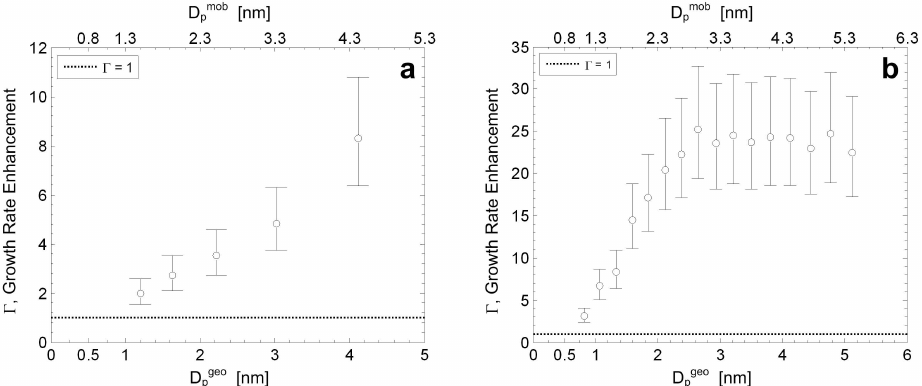
Fig. B1. Effect of systematic uncertainties in [H 2 SO 4 ] on growth rate enhancement 0 as a function of particle mobility diameter D mob p (upper abscissa) and particle geometric diameter D geo p (lower abscissa) for the NPF event observed on (a) 7 August 2009 (09:50, NCCN) and on (b) 19 September 2010 (12:40–13:00, NCAR). Values of 0 calculated using the median values of [H 2 SO 4 ] are presented as open circles. Resulting upper and lower limits on 0 , based on lower and upper limits on [H 2 SO 4 ] known to within a factor of 1.3, are shown for each value of 0 as horizontal bars. A line indicating 0 = 1 is shown for reference. Geometric particle diameters were estimated according to Larriba et al.